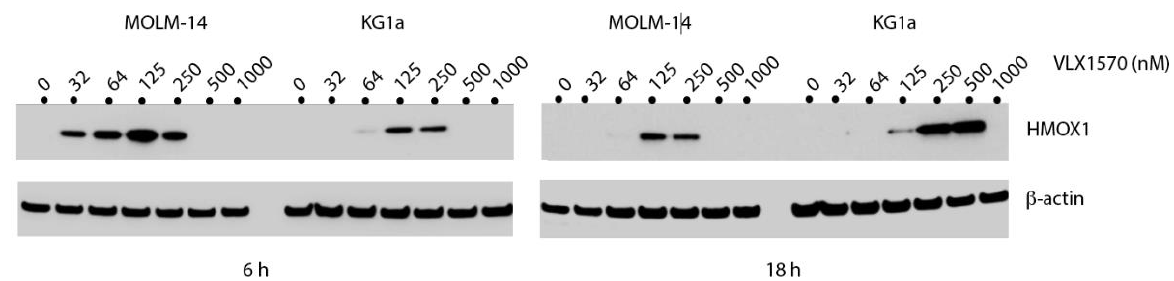
Figure 4. Induction of HMOX1 expression by VLX1570 in MOLM-14 and KG1a cells. Cells were exposed to the indicated concentrations of VLX1570 for 6 or 18 h and extracts processed for immunoblotting.